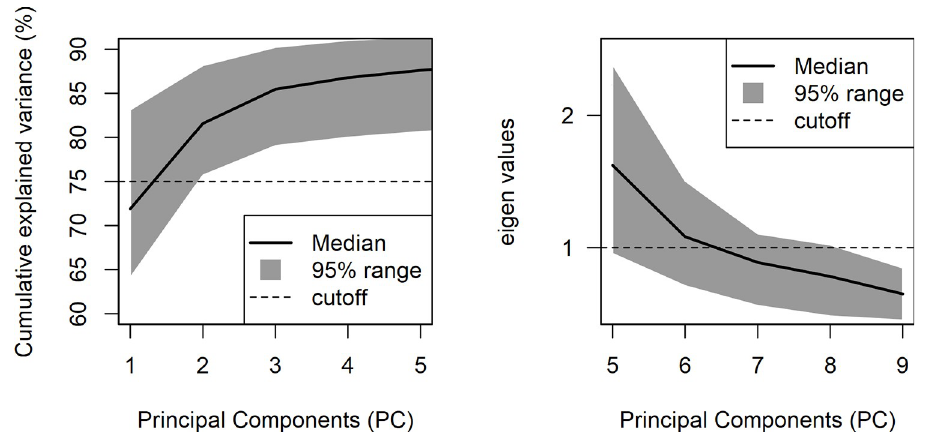
Fig 5. PCA distributions. The panels explain the decisional process employed to choose the number of components in WGHT_PD and WGHT_SD, based on the data of Study 1. Specifically, the left panel shows the distribution (median and 95% range) of the cumulative explained variance of the first five PCs across all PCAs. The right panel is a scree-plot representing PCs 5 to 9 focusing on the eigenvalue = 1